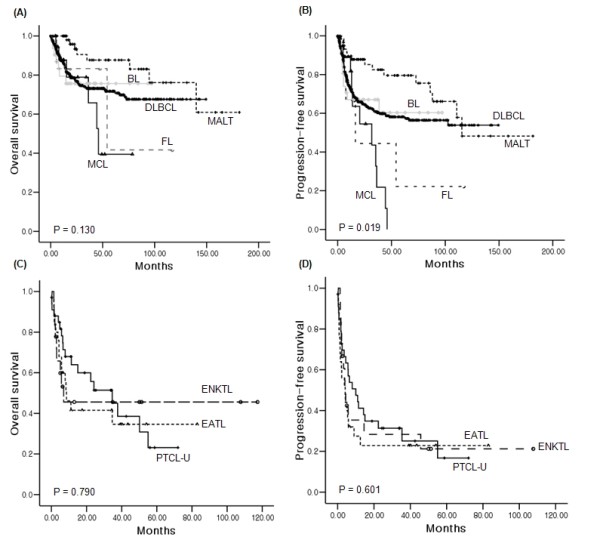
Comparison of survival curves based on the histologic subtypes. (A, B) Overall and progression-free survival curves according to subtype of B-cell lymphoma. MALT lymphoma showed better OS than other subtypes, while BL and DLBCL showed similar OS curves to each other. (C, D) Overall and progression-free survival curves according to subtype of T-cell lymphoma. There were no significant differences among PTCL-U, EATL, and ENKTL.